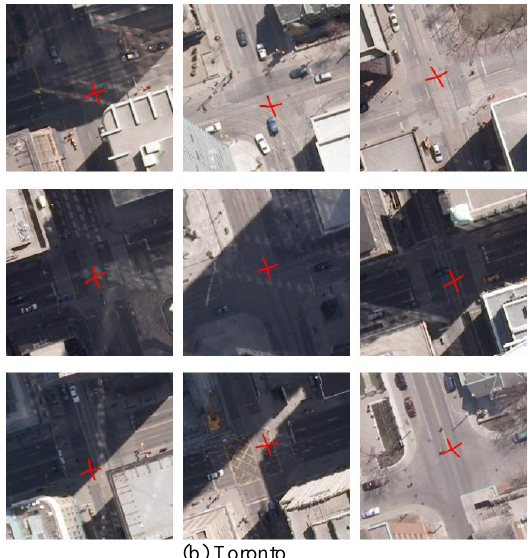
Figure 6. Results of road intersection detection and recognition